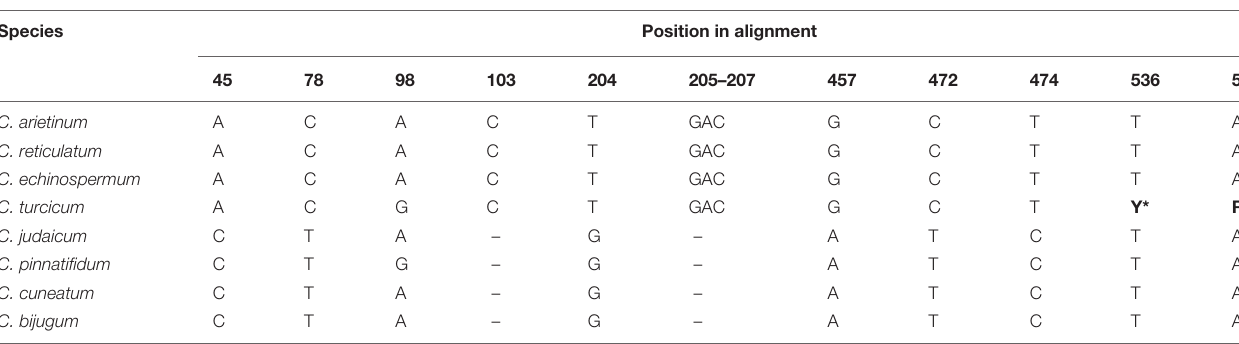
TABLE 6 | Species diagnostic differences in ITS region.